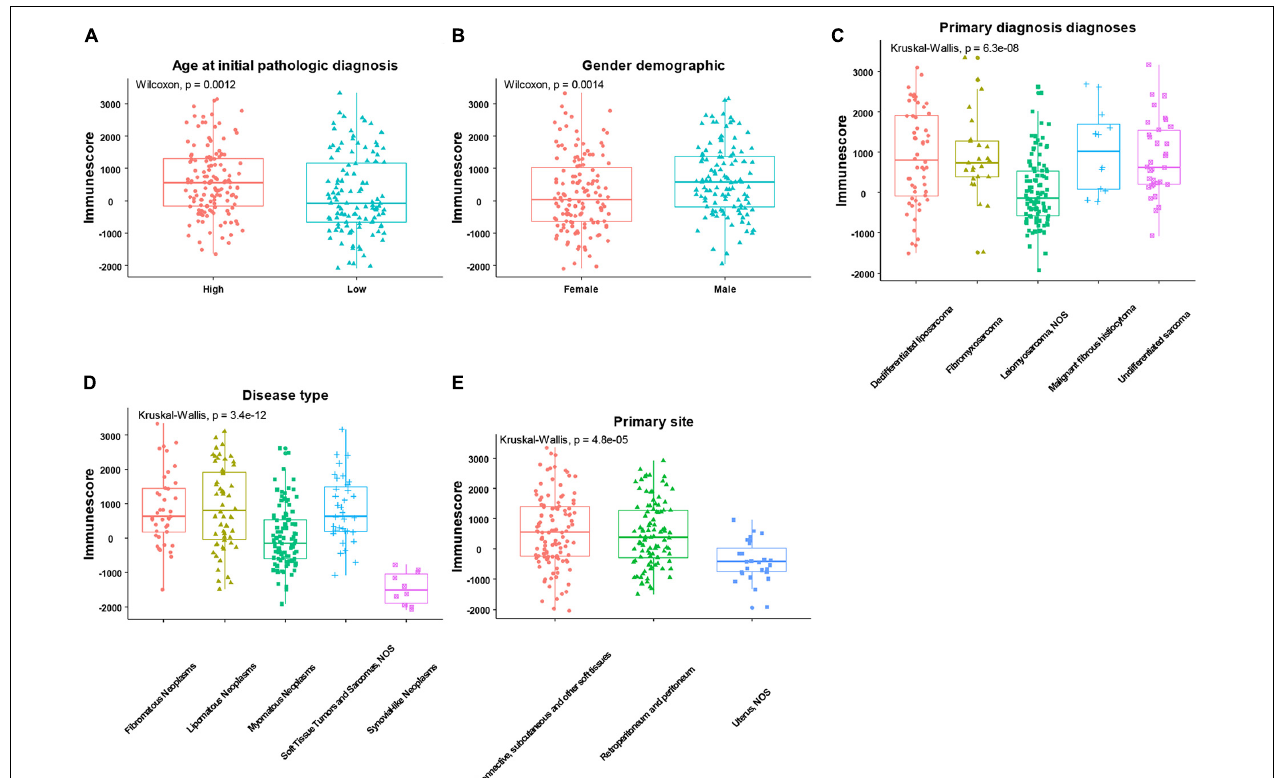
FIGURE 2 | The significant associations between immune score and the clinical factors of patients with SARC. The age (A) , gender (B) , primary diagnosis (C) , disease type (D) , and primary site (E) were significantly associated with the immune scores calculated by ESTIMATE algorithm.